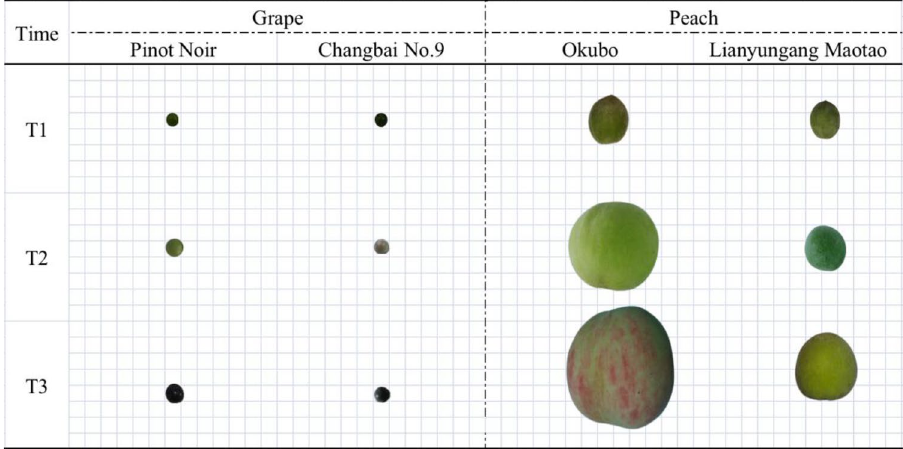
Figure 2. Wild and cultivated fruits in different periods. Comparison of fruit size changes between cultivated and wild grapes and peaches in three periods T1 represents young fruit period, T2 represents swelling period, and T3 represents maturity